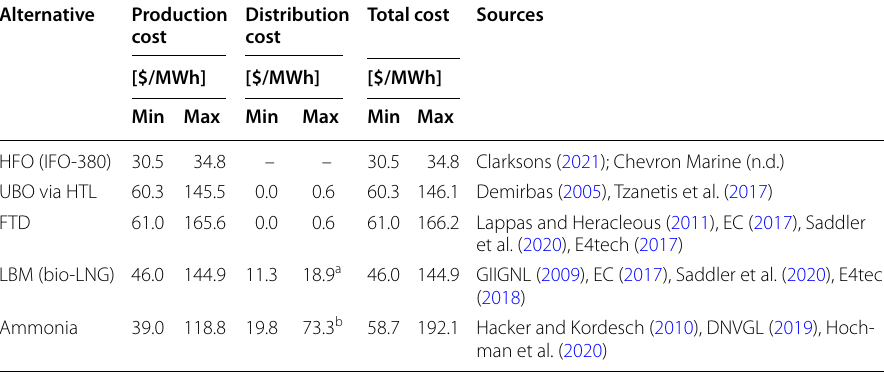
a Distribution and liquefaction costs of LBM are assumed equal to LNG b Ammonia is assumed to be stored and distributed under 1 bar and – 33 °C or 10 bar and 20 °C at equal